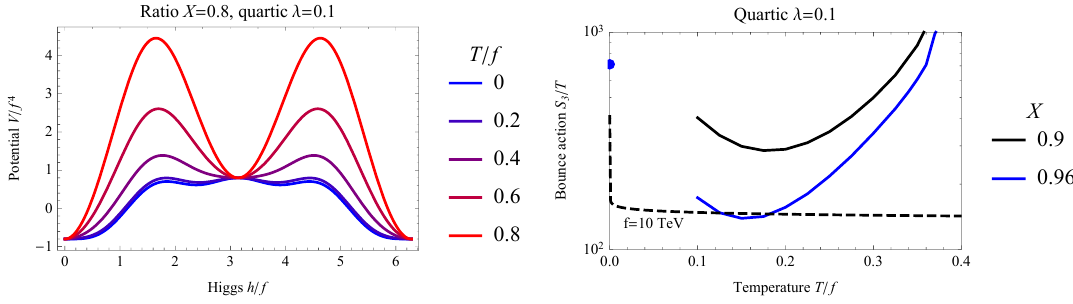
Figure 5 . We consider the model of eq. (4.14). Left : thermal potential. Right : S 3 =T action of the O(3) bounce (full curves). The dot shows the action of the O(4) bounce relevant at T (cid:28) f . Below the dashed line tunnelling is cosmologically fast during radiation domination.